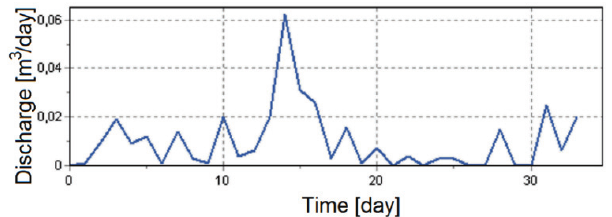
Fig. 7. The chart of 33days of intense rainfall in 2010